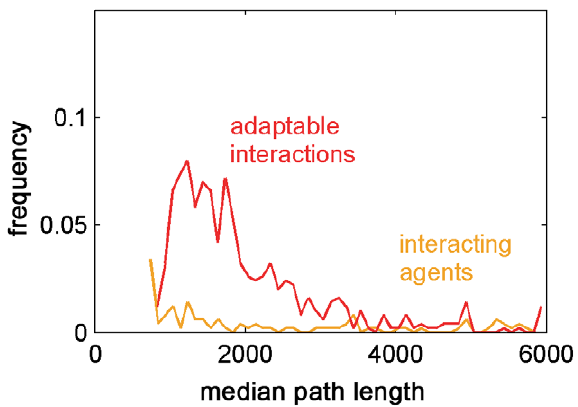
Figure 12. Distribution of median path lengths with diverse forward motion runs. When the sizes of the agents’ forward motion runs, denoted by t , are diverse, the mean median path length of agents with adaptable interactions is much lower than the other mechanisms, which are not clearly visible in the graph since they exceed the simulation length. Simulation parameters are as in Figure 9, apart from the previously constant forward motion run; here t [ ½ 0 : 3,1 (cid:2) .